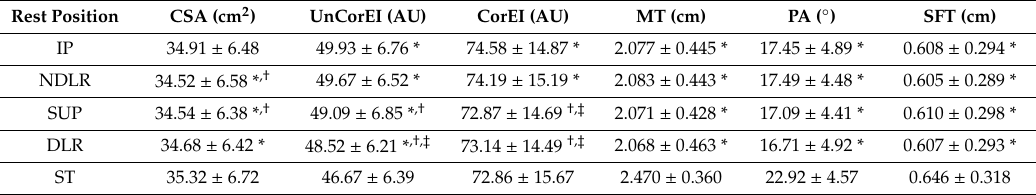
Table 4. Values for ultrasound-derived muscle morphological characteristics of the vastus lateralis after rest in di ff erent